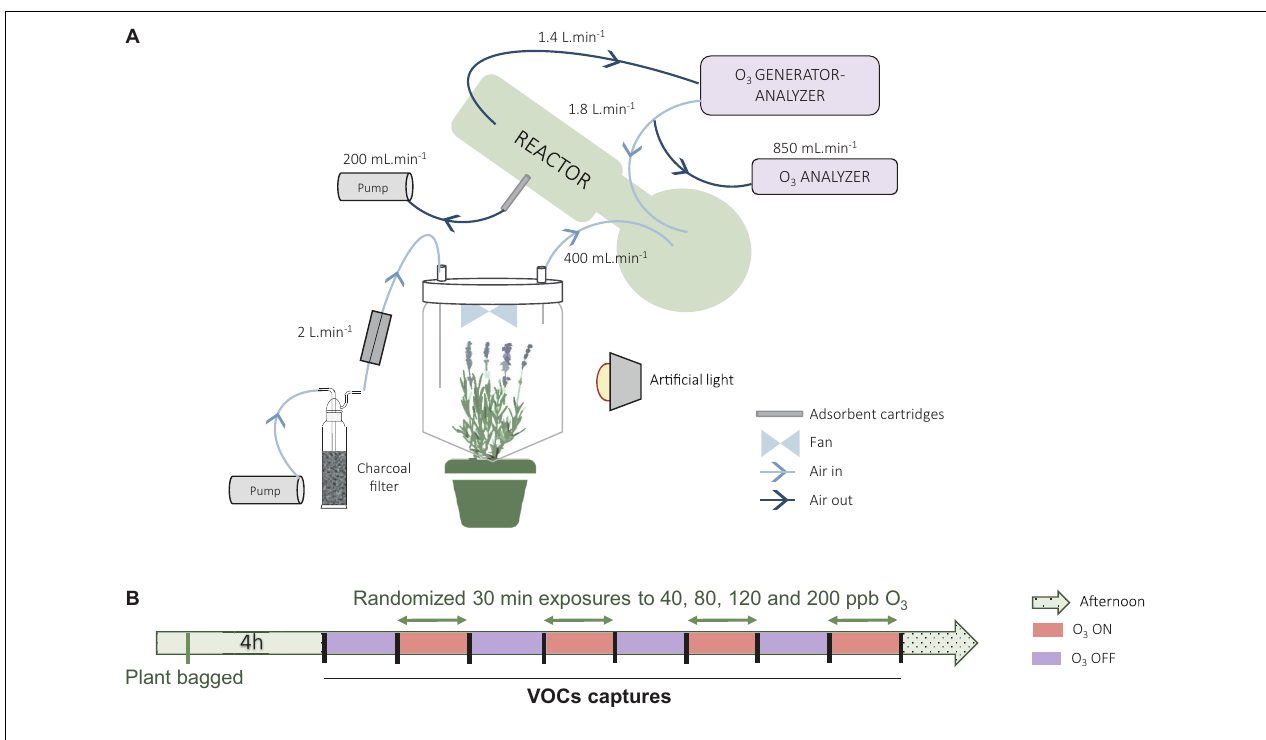
FIGURE 2 | Schematic diagram of (A) the experimental set-up presenting the exposure of flowering lavender volatile organic compounds (VOCs) to different [O 3 ] and (B) timeline of the exposure for experiment 2. We present the temporal scheme showing the 4-hour control period at the beginning followed by alternating ozone periods (red) and control periods (purple). Each period was 30 min and VOC samples were collected through adsorbent cartridges (gray bars in panel A ) at the end of each period during 10 min (including controls and ozone